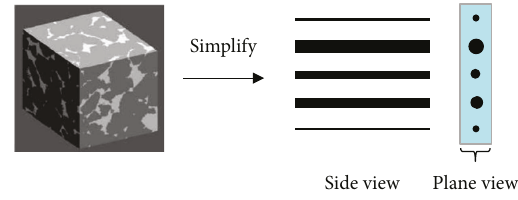
Figure 19: Schematic of capillary bundle.